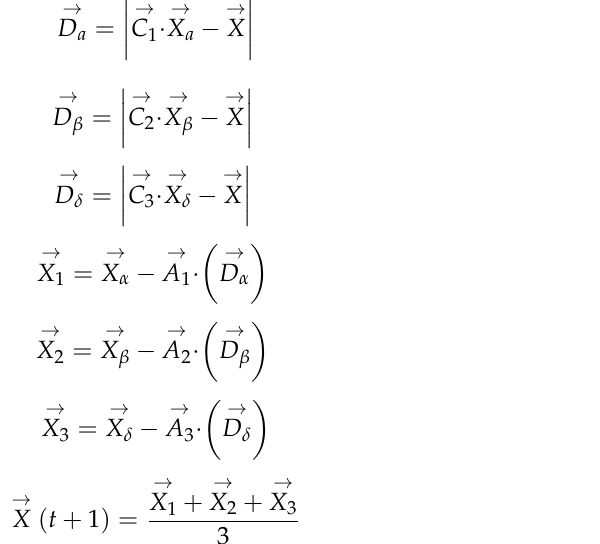
Figure 4. BGWO architecture [43]. The BGWO assumes that α , β , and δ are the (optimal) prey positions. During the opti- mization process, the three best solutions assumed to be α , β and δ can be obtained. The fol- lowing equations can be used to update the position of the wolves, while Equations (11)–(14) are obtained by determining the final position of the wolves